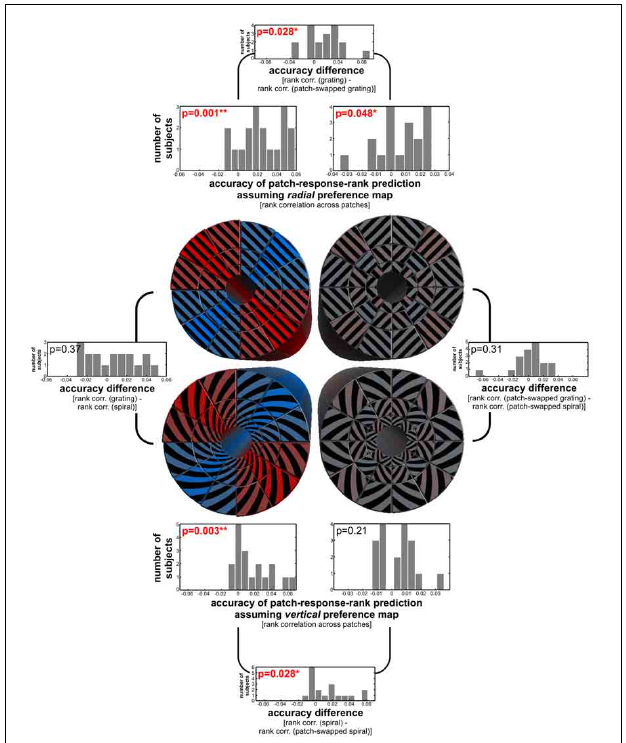
FIGURE 5 | Statistical inference for radial and vertical preference maps and preference differences. Inference is based on the accuracy with which the radial/tangential or vertical/horizontal preference model predicts the rank order of response amplitudes across patches (see Methods). The histograms show the distribution across subjects of these accuracies (Spearman r ). We performed a two-sided Wilcoxon signed-rank test on each accuracy distribution. The p -value for each effect is in the top left corner of the corresponding histogram and in bold red if it indicates a significant effect. The outer plots show differences between stimulus types in the strength of radial and vertical preference effects, and their p -values from the same two-sided signed-rank